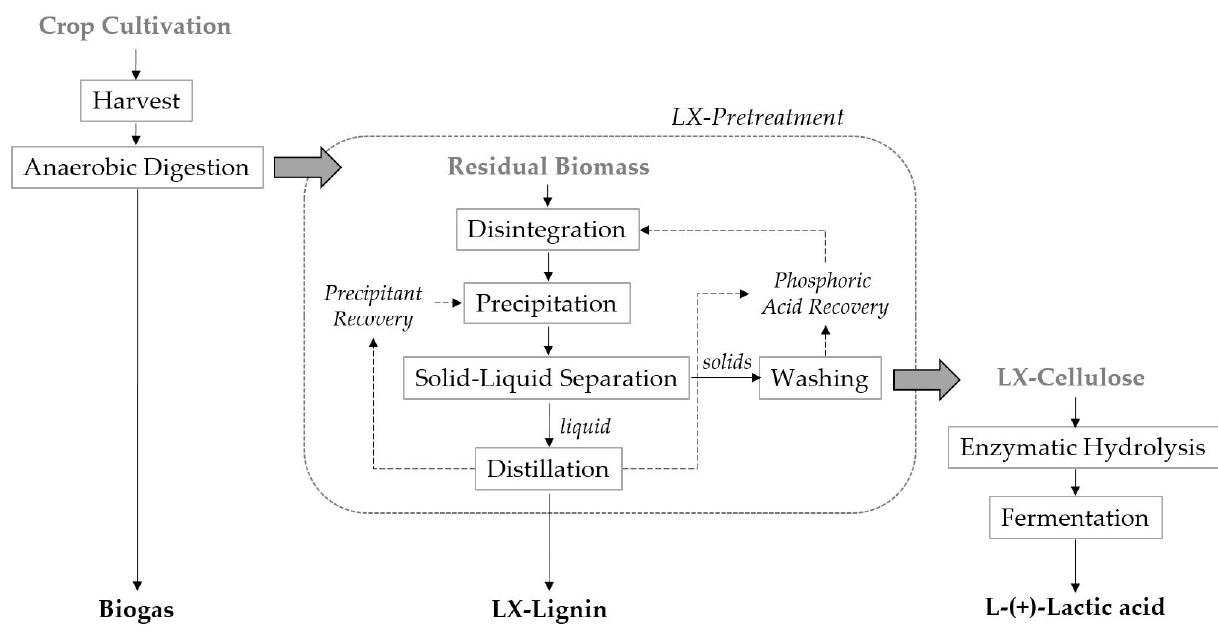
Figure 1. Schematic biorefinery process with an integrated LX-Process (LXP Group GmbH, Teltow, Germany); by following a value-adding cascade approach, several products can be gained from one renewable source.